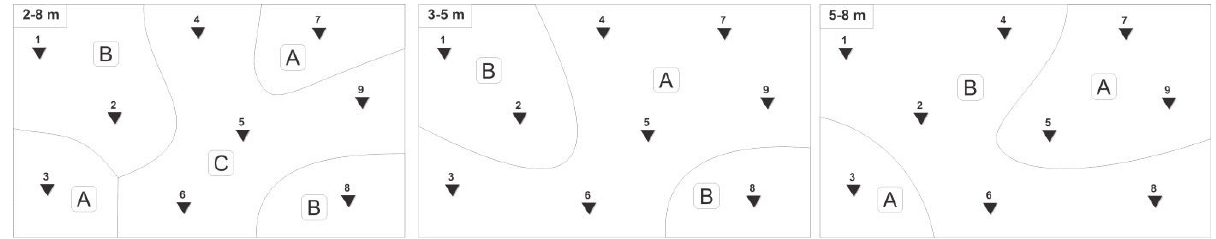
Figure 8. Dendrograms of clustering hierarchy of curves M= f(z) from CPTU testing sites within the range of depth of 2 - 8 m for the strongly smoothed function ( K =6) and weakly smoothed function ( K =16).